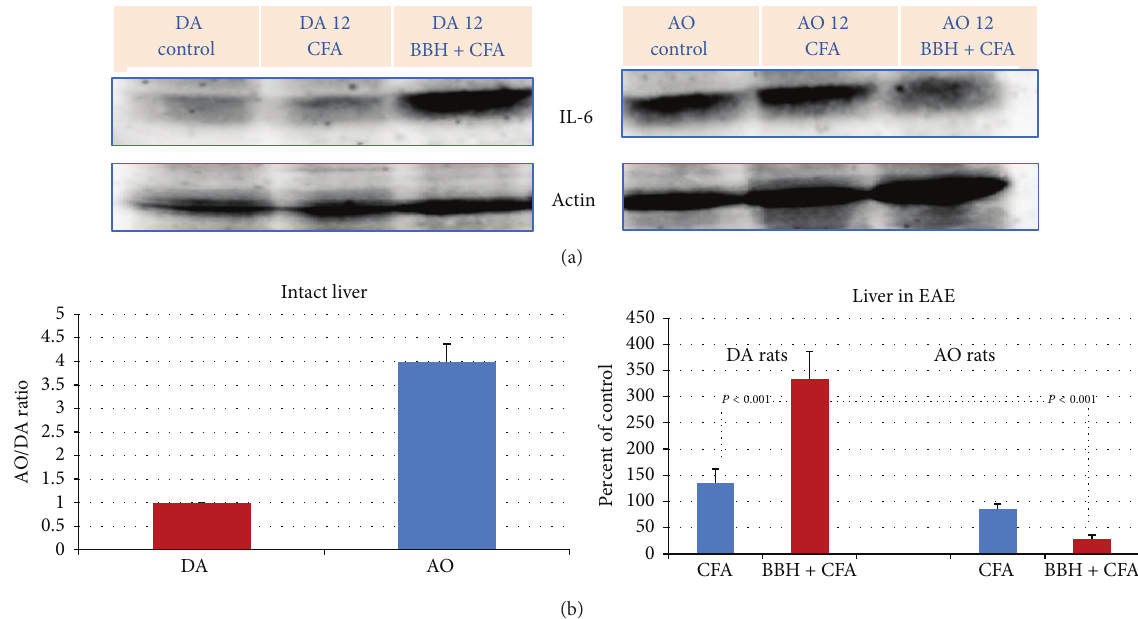
Figure 3: Expression of IL-6 in the livers of EAE-prone DA and EAE-resistant AO rats. (a) Representative western blots indicate the IL-6 protein ( ∼ 25kD; range 20–25 kD), detected by mouse anti-rat antibody to IL-6. The liver samples were obtained from intact rats and from rats treated by bovine brain homogenate (BBH) and complete Freund’s adjuvant (CFA) or by CFA at the time of first attack in EAE-prone rats (day 12). As a loading control the blots of 𝛽 -actin protein (37–50 kD) are shown. (b) Relative protein expression is shown as AO/DA ratio (intact liver) and as the percent of control (liver in EAE). All band densities were normalized corresponding to 𝛽 -actin. Analyses were made in tissue samples, prepared as a pool from 3 rats in three independent experiments. Data represent mean ± SE.